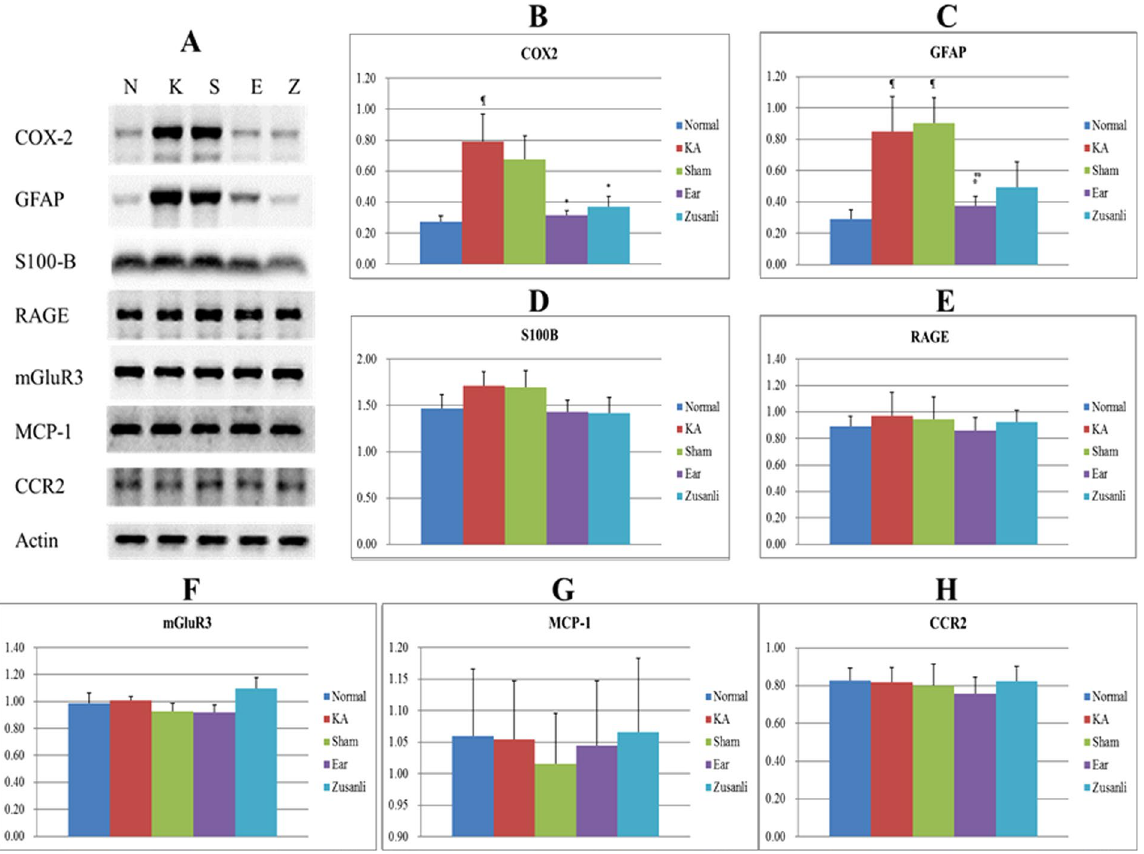
Figure 2. Western blot findings for the effects of electrical stimulation at the ear and electro-acupuncture at ST36–ST37 on the levels of COX-2, GFAP, S-100B, RAGE, mGluR3, MCP-1, and CCR2 in kainic acid (KA)- induced epileptic seizure rats. The levels of COX-2 increased in the KA group (K) and sham group (S), and decreased in the auricular group (E) and Zusanli group (Z) ( A and B ). The levels of GFAP increased in the KA group and sham group and decreased in the auricular group and Zusanli group ( A and C ). The levels of S100-B ( A and D ), RAGE ( A and E ), mGluR3 ( A and F ), MCP-1 ( A and G ), and CCR2 ( A and H ) among the normal group (N) and the KA, sham, auricular, and Zusanli groups. ¶ p < 0.05 compared with the value of N; * p < 0.05 compared with the value of K; # p < 0.05 compared with the value of S; n =